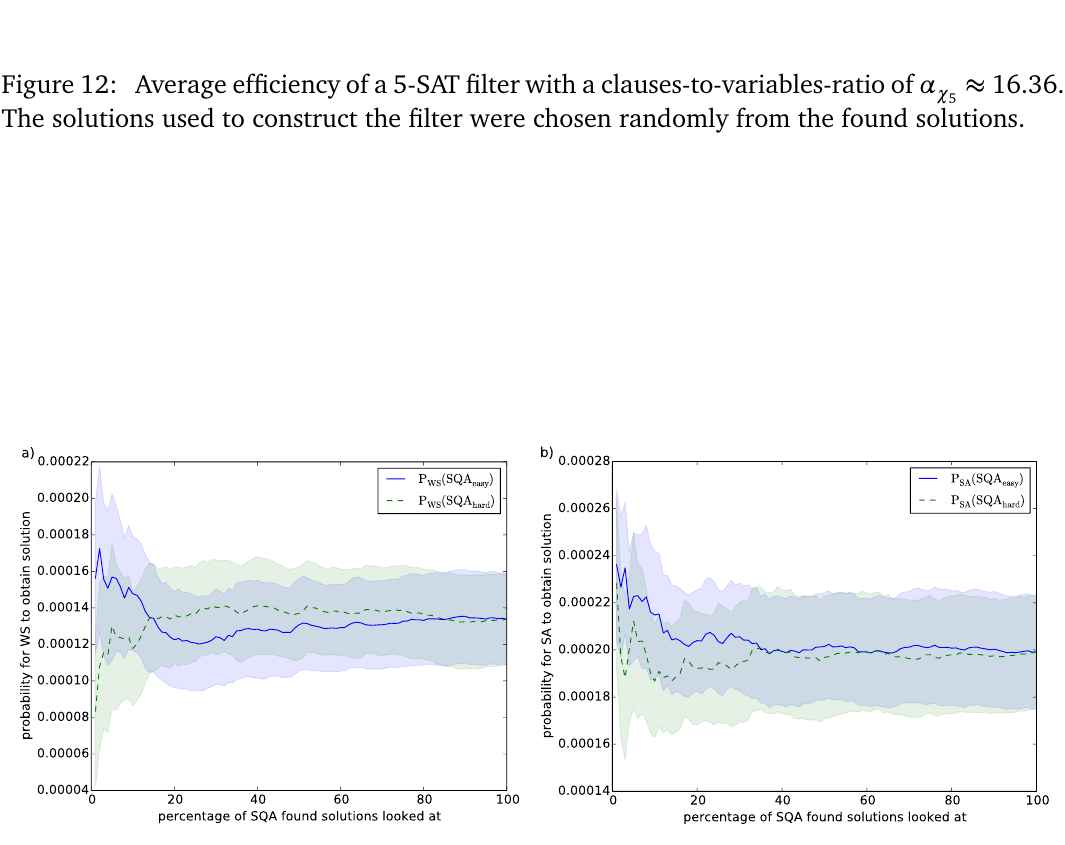
Figure 13: Probability for a) WS and b) SA to find the SQA-hardest and SQA-easiest solutions. The x-axis indicates the percentage of easiest and hardest SQA-found solutions, running SQA 1000 times on 20 randomly generated 5-SAT instances with n = 50 variables and a clauses- ≈ 16.36. An average was taken over the to-variables-ratio of α χ 5